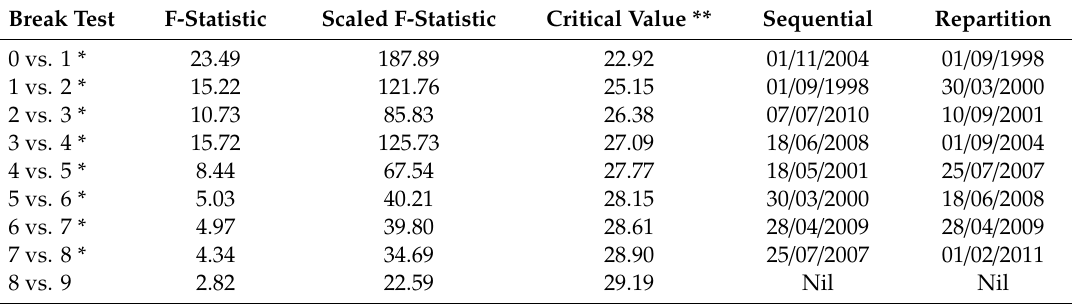
Table 4. Local AFFM stability diagnostic